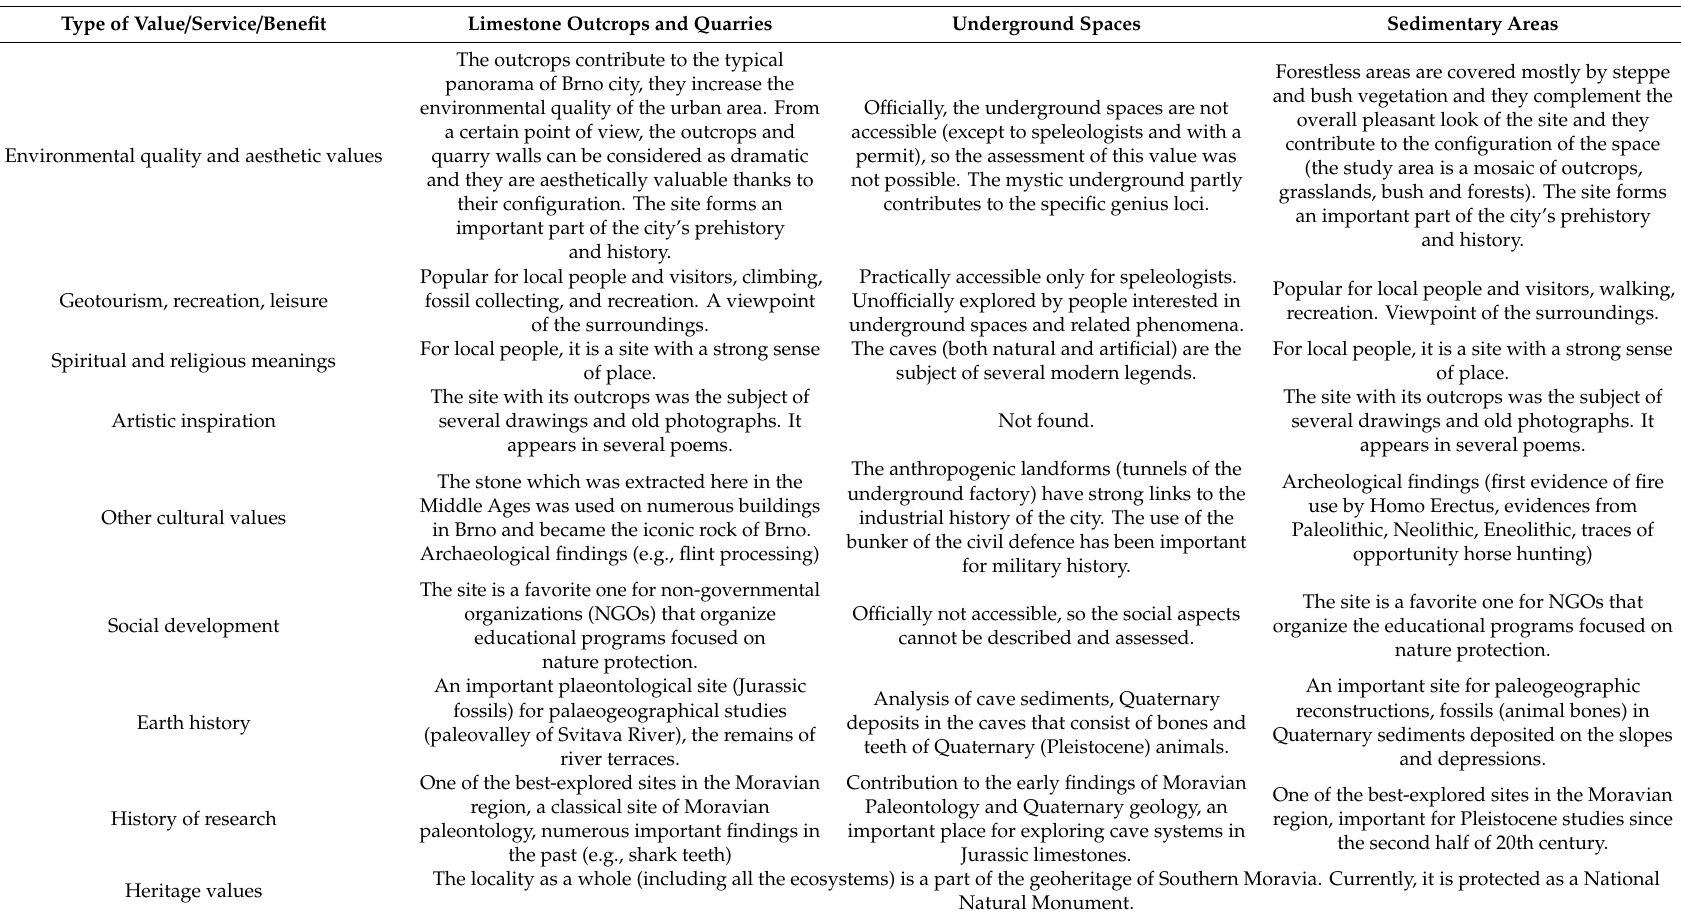
Table 5. Identification and description of the ecosystem